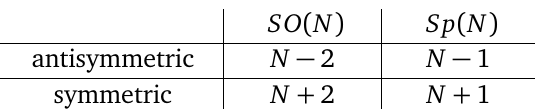
Figure 15: The phase diagram for SO ( N ) for k < N / 2 − 2. There are two phase transitions between different infrared TQFTs.